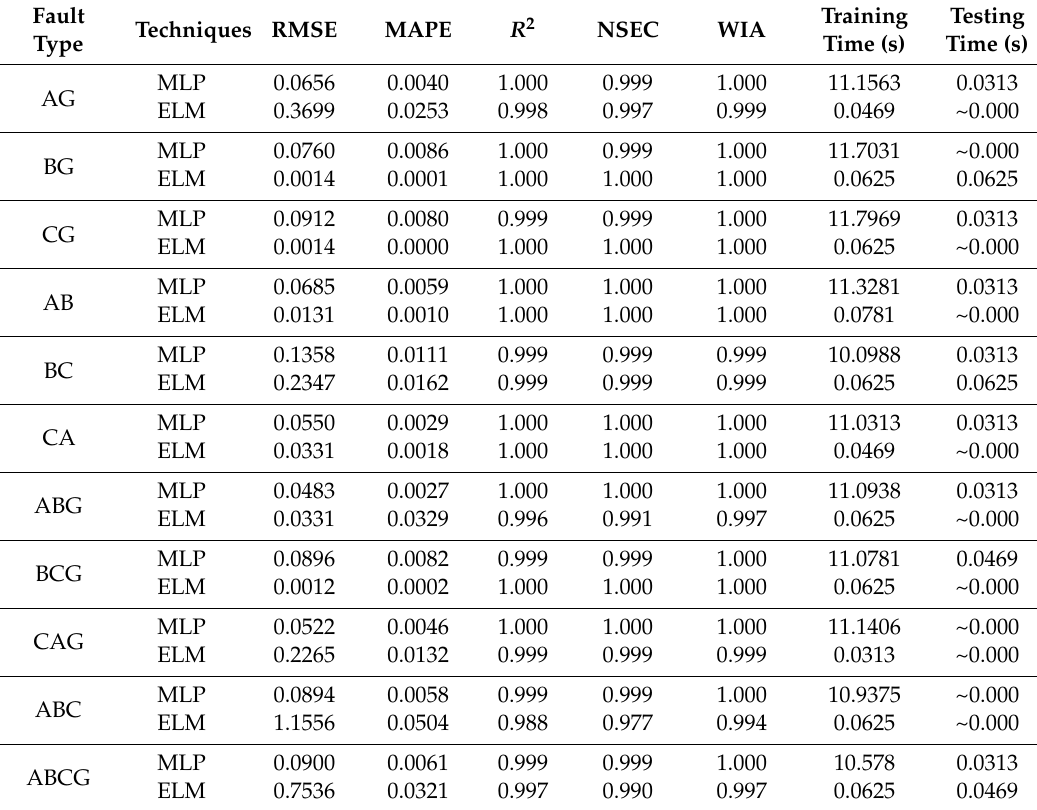
Table 6. Performance measurements of MLP and ELM for locating faults in a distribution system with an unbalanced